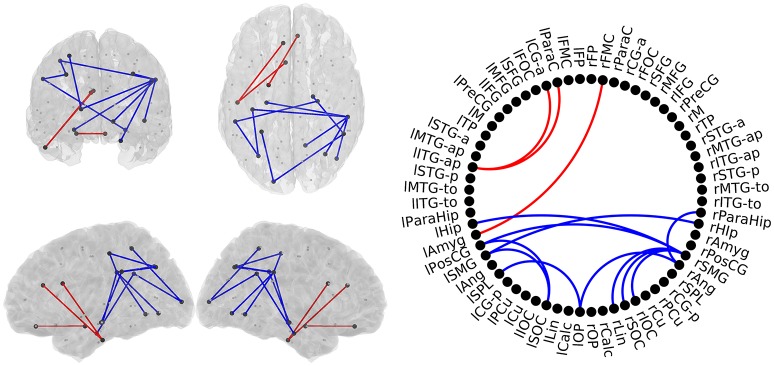
Links with significantly different FC-values in the comparison between Healthy Controls (HC) and Subjective Cognitive Decline (SCD) groups. Left: Posterior, superior, left and right views of the brain. Right: Circle plot shows a schematic view of the significant links. Red lines indicate an increased FC-value in SCD respect to HC. Blue lines indicate a decreased FC-value in SCD respect to HC.